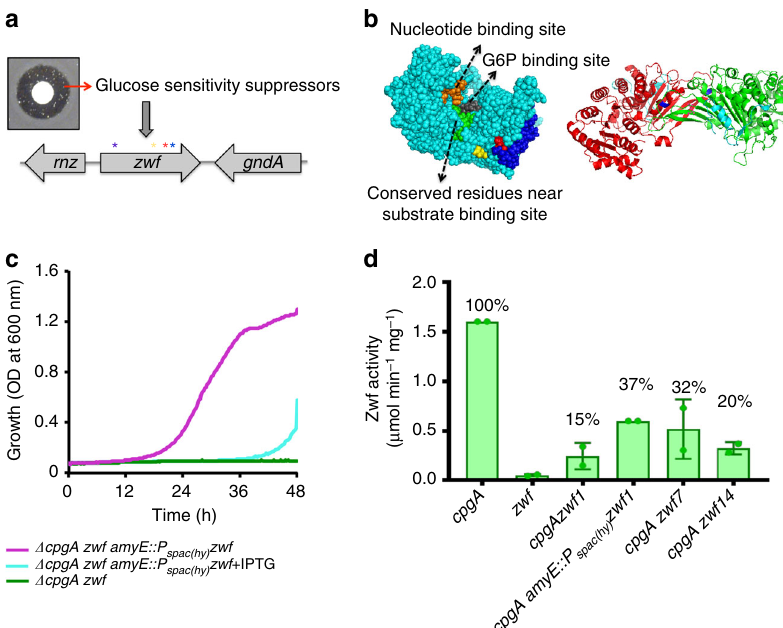
Fig. 3 Suppression of Δ cpgA glucose sensitivity by reduction in Zwf activity. a Δ cpgA suppressor mutants were recovered (after ≥ 24 h) from the zone of clearance generated by glucose on MH medium at 37 °C. Four independent mutations in zwf are shown (see Supplementary Table 1). b Left panel: B. subtilis Zwf was modeled (I-TASSER) to generate a space- fi ll view (cyan) highlighting the nucleotide binding site (orange), glucose-6-phosphate binding site (gray), and conserved residues (green). Suppressor mutations affect D449N (yellow), W455R (red), W455stop (truncation of C terminus loop shown in blue). Right panel: suppressor mutations led to changes in Zwf dimer (red and green protomers) as modeled on the Leuconostoc mesenteroides (PDB: 1DPG) structure (45% identical to B. subtilis Zwf). Suppressor mutations affected V191L (blue) at the dimer interphase and W455stop (truncation shown in cyan). c Growth of a Δ cpgAzwf double deletion (green line) in MSMM with 0.8% glucose is rescued by amyE::P spac(hy) zwf when uninduced (low level of Zwf, magenta line), but not when Zwf is induced with IPTG (cyan line). d Speci fi c activity of Zwf in Δ cpgA suppressor strains monitored in cell extracts. NADPH formation (A 340 vs. time) as a result of G6P oxidation by Zwf was measured and is shown as the percentage relative to the Δ cpgA parent strain ( n = 2, 2 biological replicates with each consisting of three technical